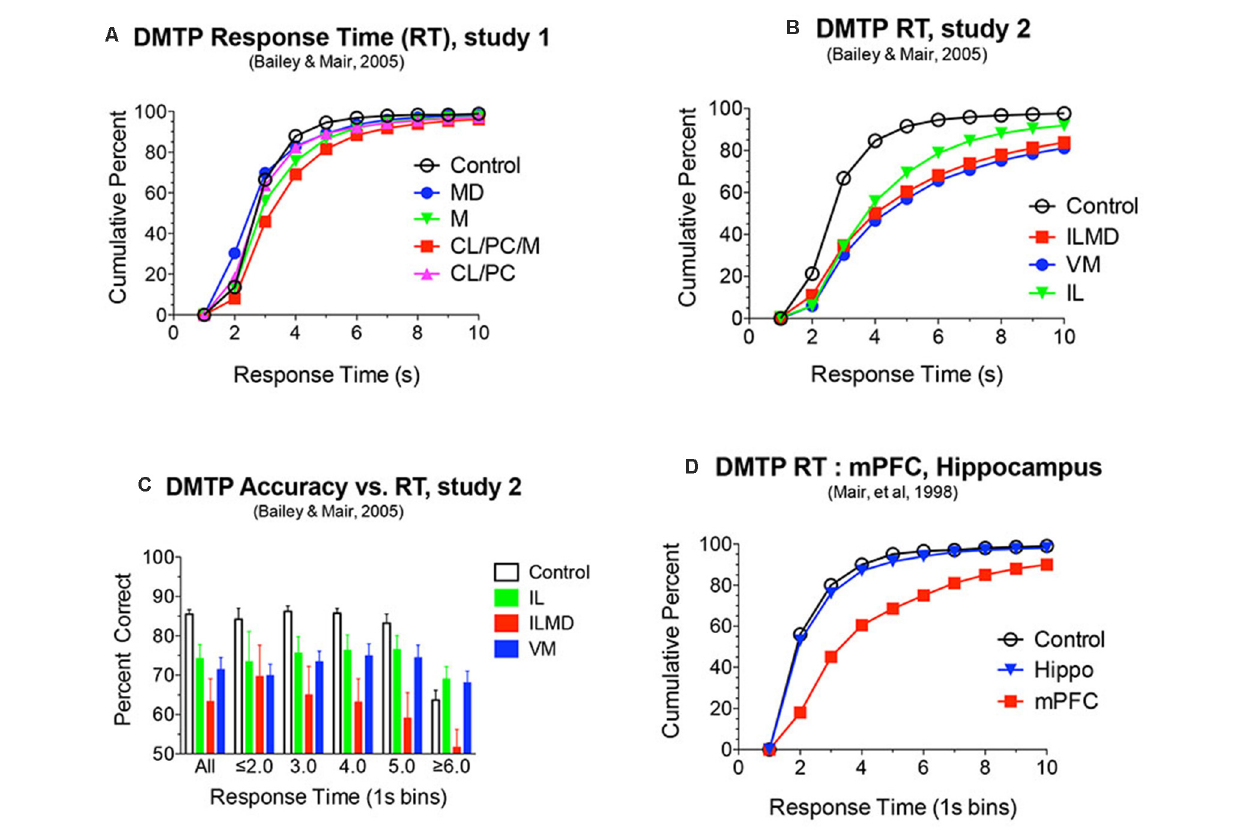
FIGURE 5 | (A,B,D) Response time (RT) analyses of DMTP choice plotted as cumulative functions. RT was measured from the lever press marking the end of the memory delay to the choice press (see Figure 6 ). RT was increased significantly by rostral intralaminar (IL), ventromedial (VM), and large lesions damaging IL and the mediodorsal (MD) nuclei (ILMD; B ). These same lesions produced delay independent impairments of DMTP ( Figure 4B ). To test whether the increase in RT could account for the decrease in DMTP accuracy, separate analyses were conducted for responses divided into discrete RT bins. Restricting responses to 1 s time bins did not affect significant deficits produced by each of the lesions for RT bins with sufficient numbers of responses to support these analyses (C) . mPFC, but not hippocampal, lesions were associated with a similar increase in DMTP RT (D) and accuracy Figure 4H . Data are replotted from studies